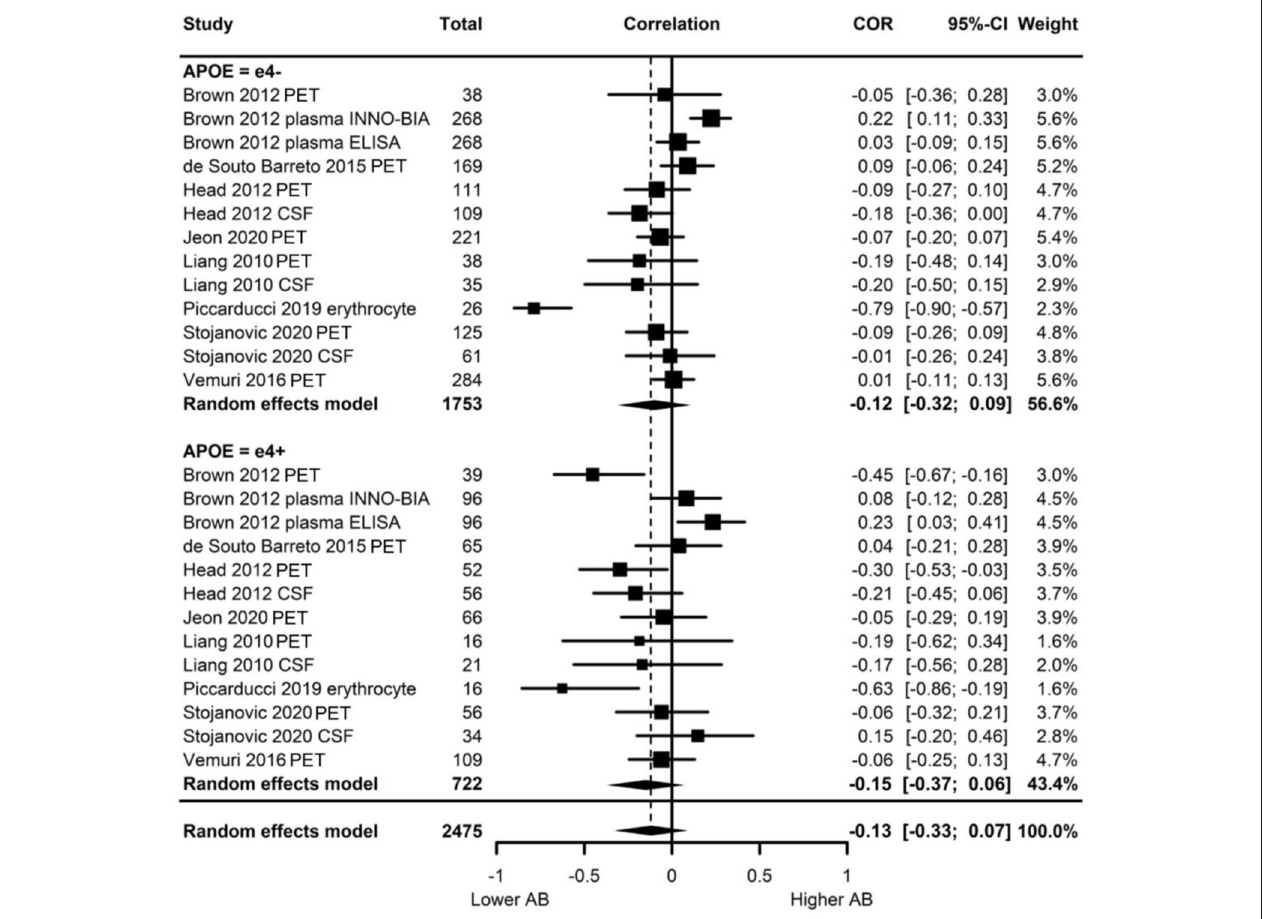
FIGURE 4 | Forest plot indicating the association between physical activity and A β with carrier (e4 + ) and non-carrier (e4–) subgroups. Subgroup moderation test indicated no significant difference between APOE groups ( p =